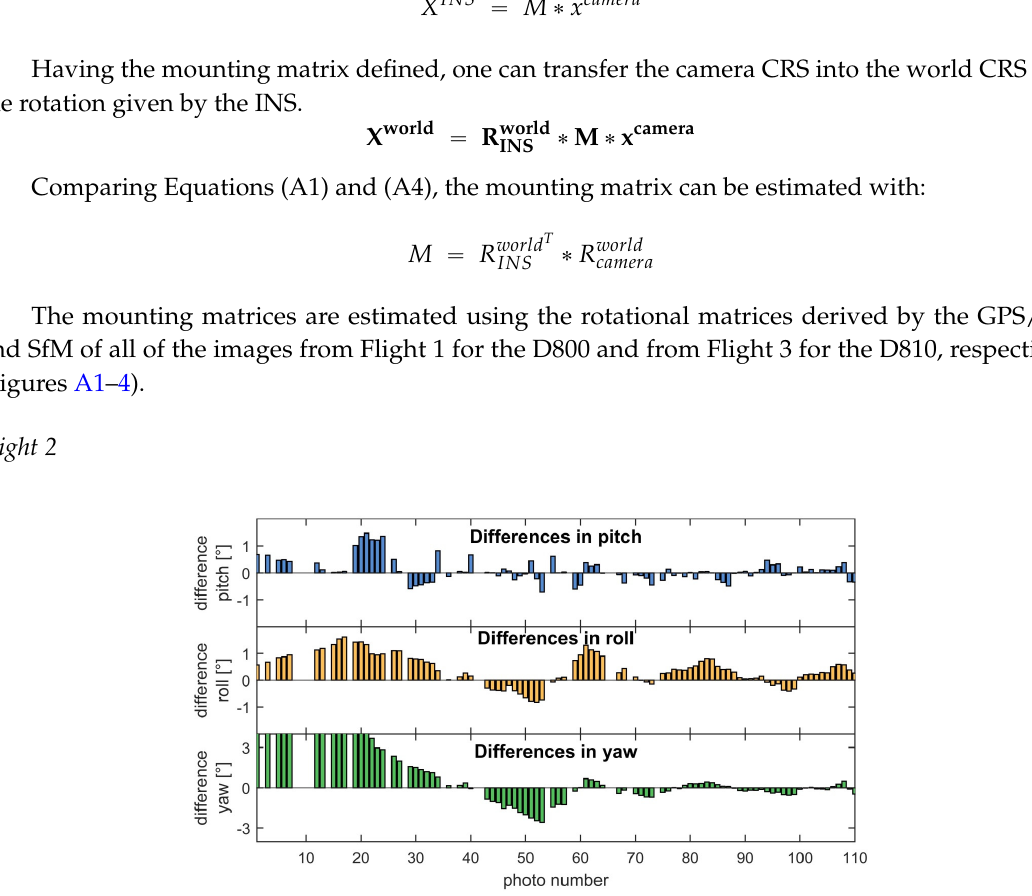
Figure A2. Histogram of differences between the indirect (SfM-computed) angles and those from the GPS/INS from Flight 2 after mounting calibration. The first images acquired during the initial state of GSP/INS are dismissed.